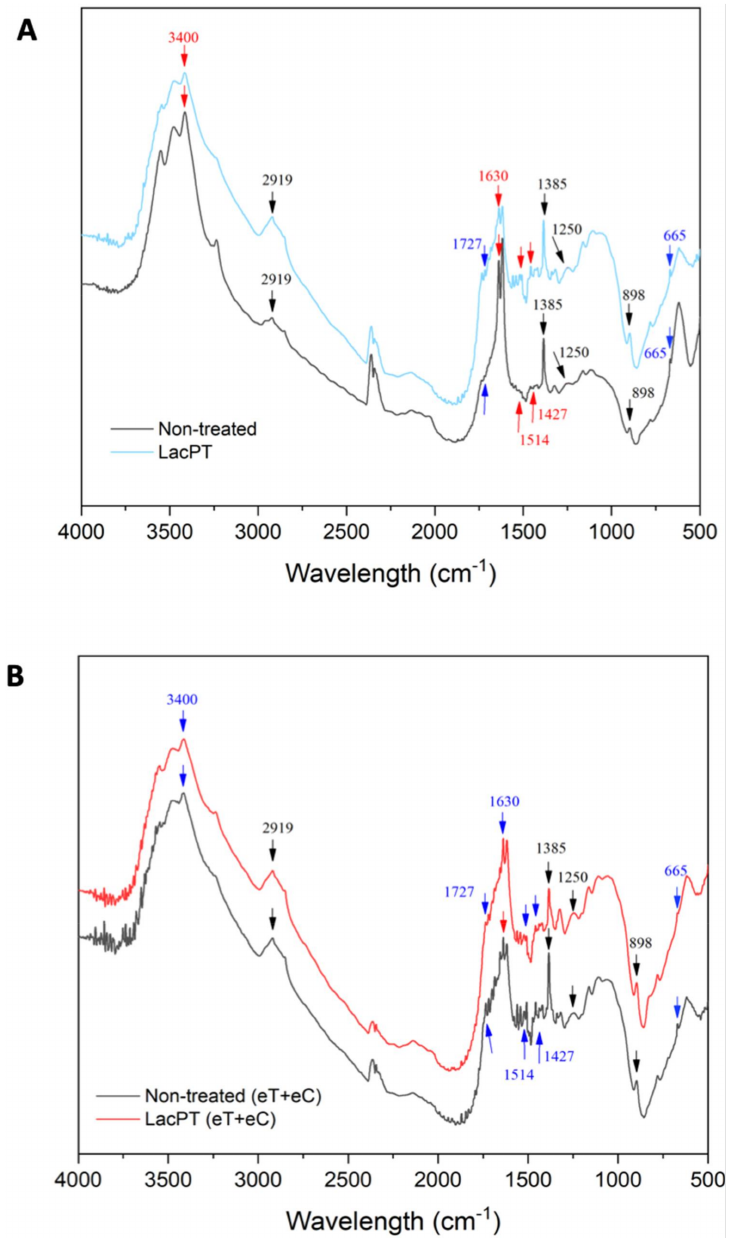
Figure 10. Fourier transform infrared spectra of raw and delignified pineapple leaf waste for Control (C) ( A ), and elevated temperature + elevated CO 2 (eT+eC) ( B ). Pretreatment conditions: Laccase load of 228 U/g for C and 350 U/g for eT+eC, 0.84% ( w / v ) Vanillin and 54.2 ◦ C for both